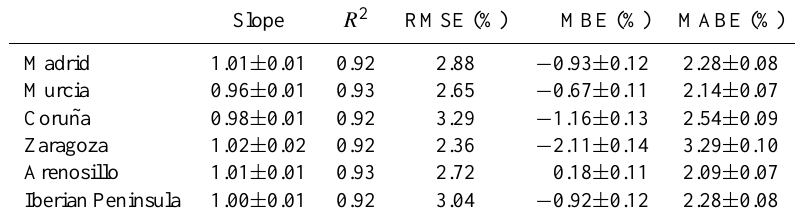
Table 2. Parameters obtained in the correlation analysis between satellite and ground-based measurements. Slope R 2